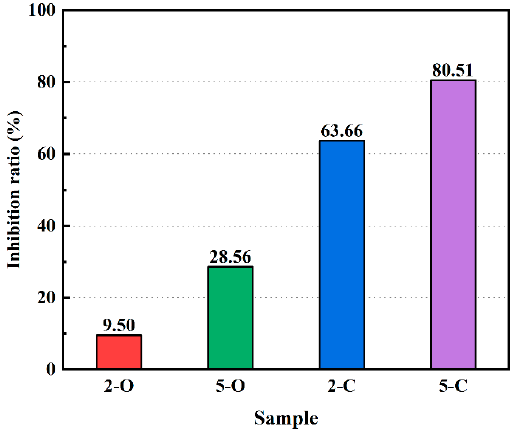
Figure 8. Inhibition ratios of samples under sulfate attack.